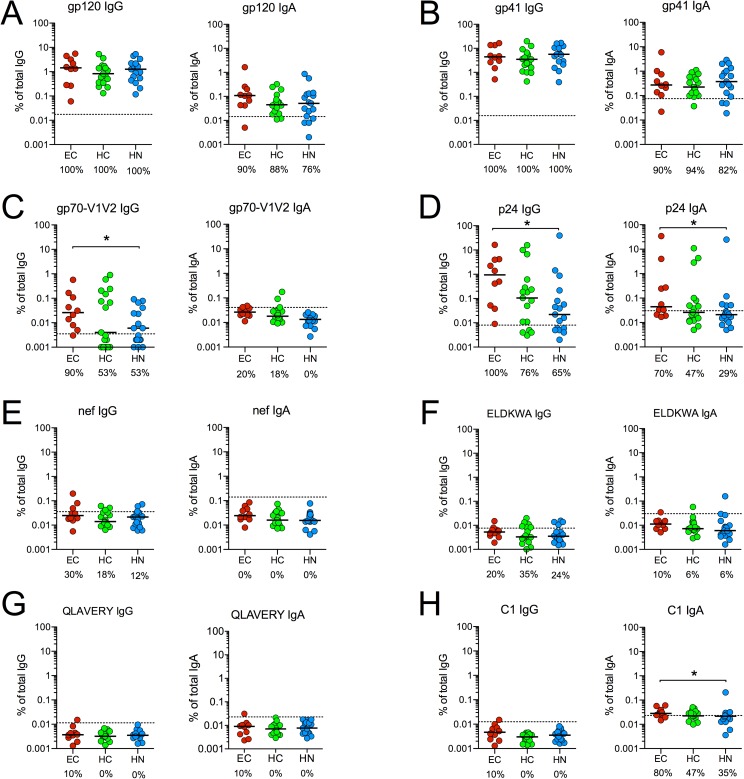
Magnitude of HIV-specific antibody responses.The average IgG and IgA sp. act. at T1 and T2 to (A) gp120 consensus B, (B) gp41BAL, (C) gp70-V1V2 Case A2, (D) p24HXB2, (E) nef and (F) gp41 ELDKWA peptide is presented as the percentage of antibody within each Ig isotype. Also shown is the sp. act. to (G) gp41 QLAVERY peptide at T1 and (H) C1 peptides at T2. Bars denote medians. Dashed lines represent the mean + 3SD of Neg controls. The frequency of subjects with positive responses is presented below each graph. *p < 0.05 by two-tailed Mann-Whitney rank sum test.